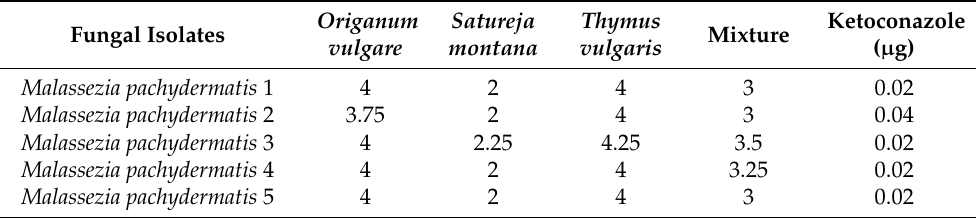
Table 4. MIC values of the tested EOs and mixture expressed in percentage ( v / v ) against the selected Malassezia pachydermatis